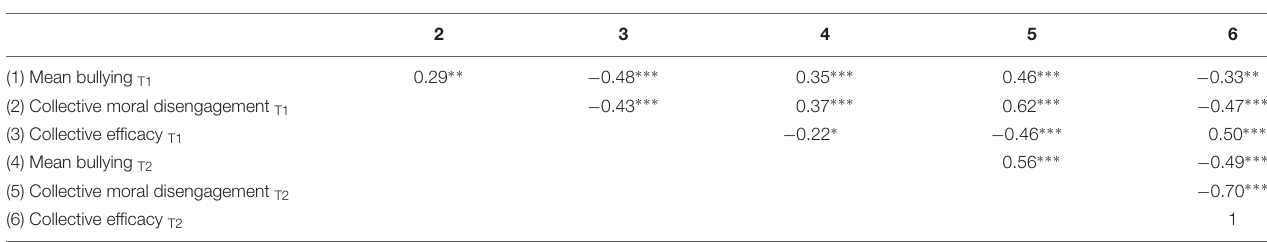
TABLE 3 | Correlations for class level variables ( M =